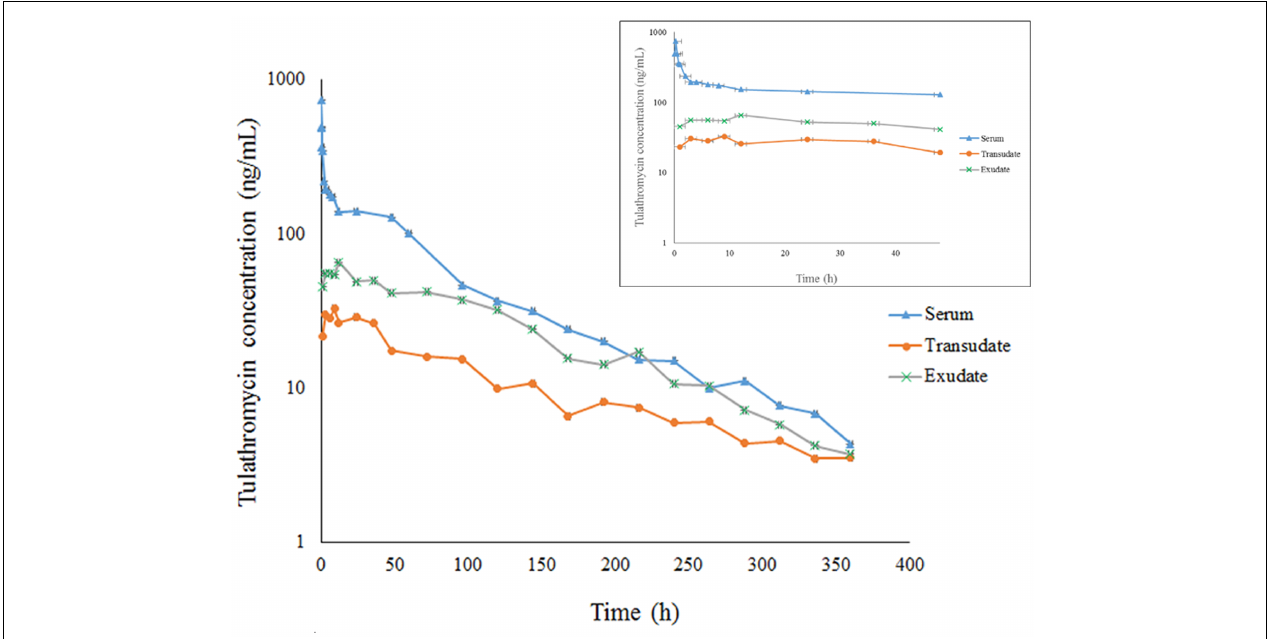
FIGURE 2 | The concentration-time curve for tulathromycin in serum, transudate and exudate after i.m. administration at a dosage of 2.5 mg/kg body weight (for clarity the small graph depicts the drug concentrations in the first 48 h post-administration).